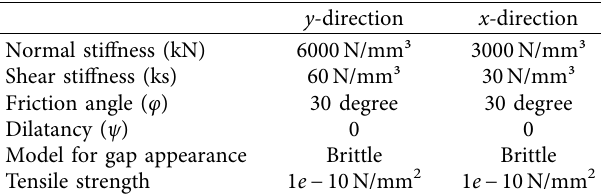
Table 2: Material properties of the interface Coulomb friction model.